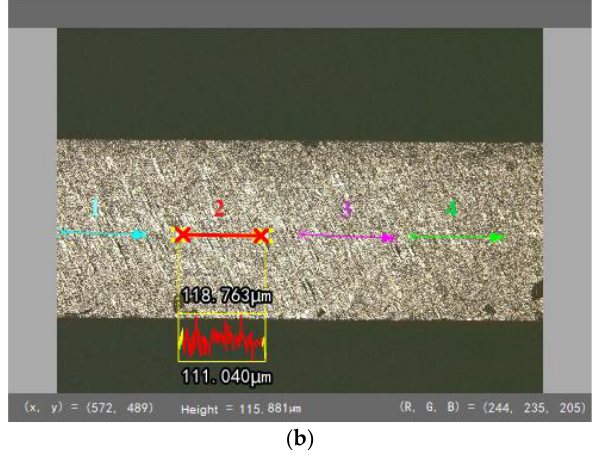
Figure 2. Surface roughness measurement at 65,000 rpm and 0.2 μm/z . ( a ) Three-dimensional topography of sidewall surface. ( b ) Two-dimensional surface.